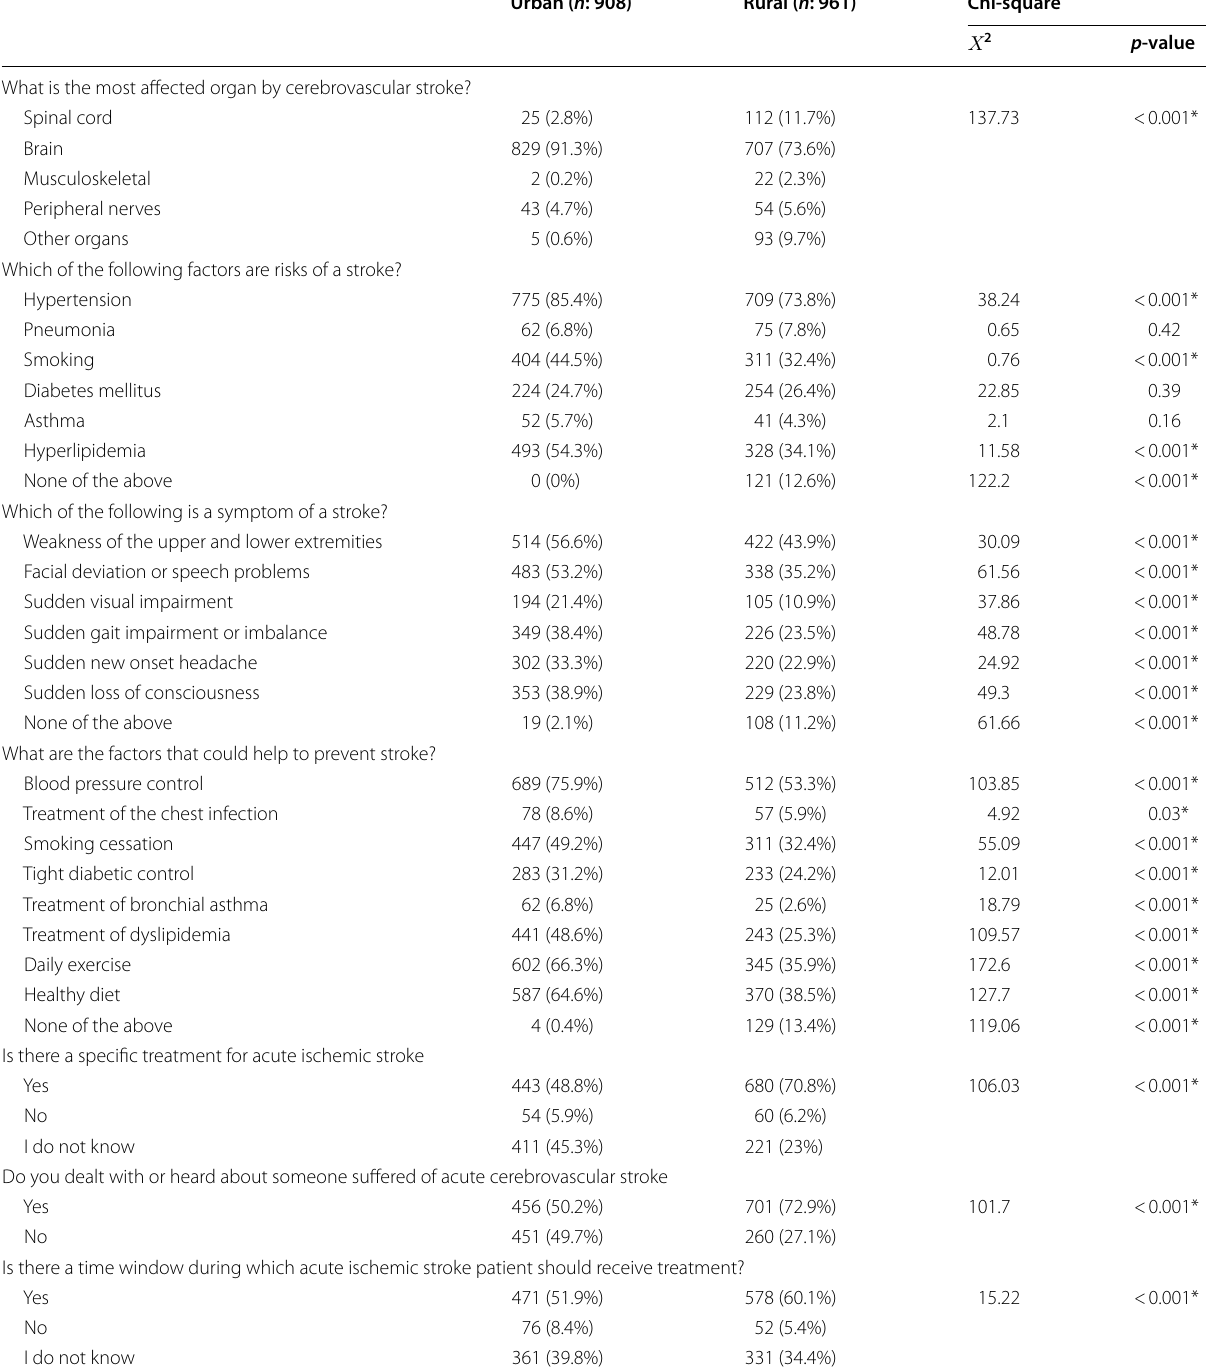
Table 3 Stroke knowledge and awareness among studied participants